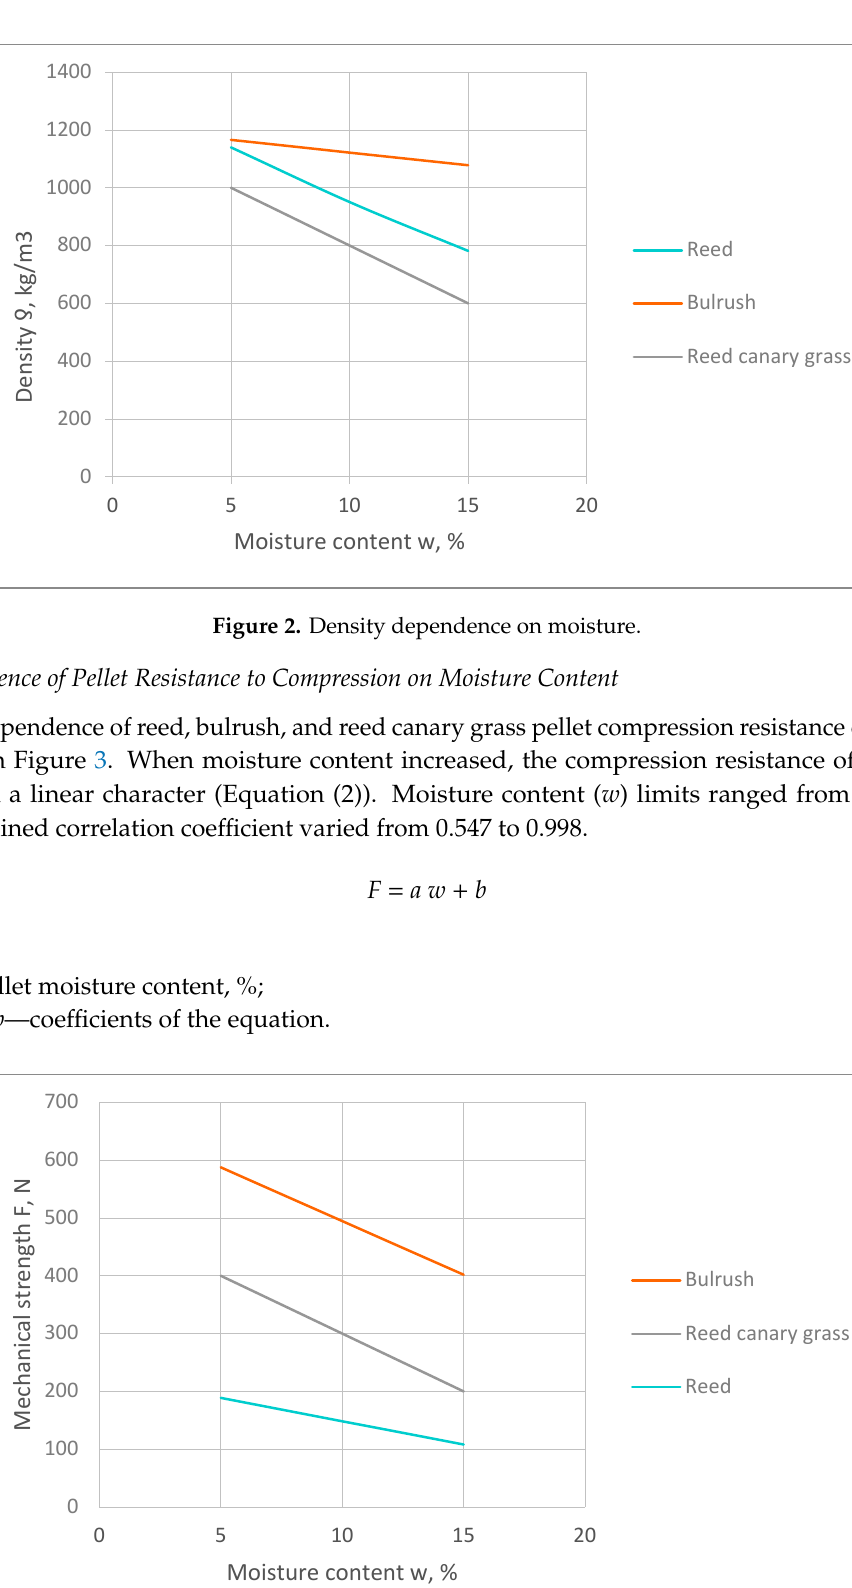
Figure 3. Dependence of pellet resistance to compression on moisture.